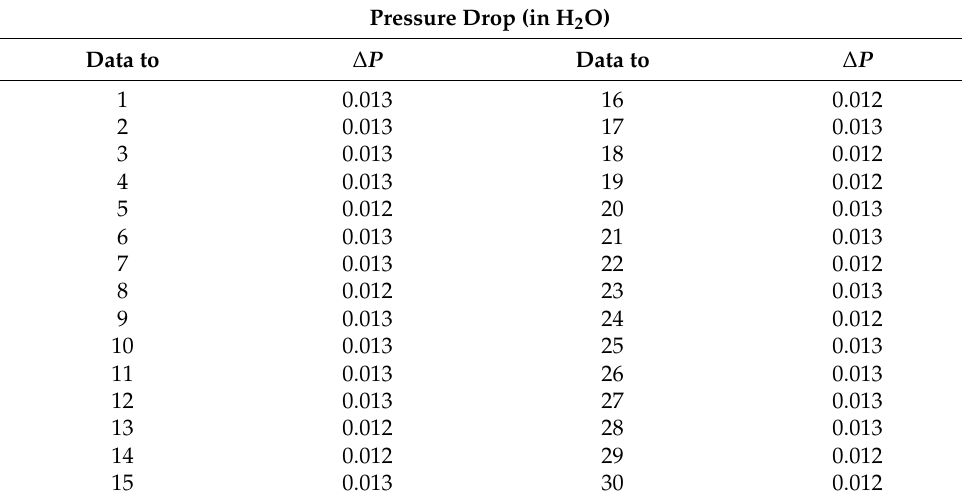
Table 3. Pressure drop data from the baseline case at a velocity of 2 m/s.